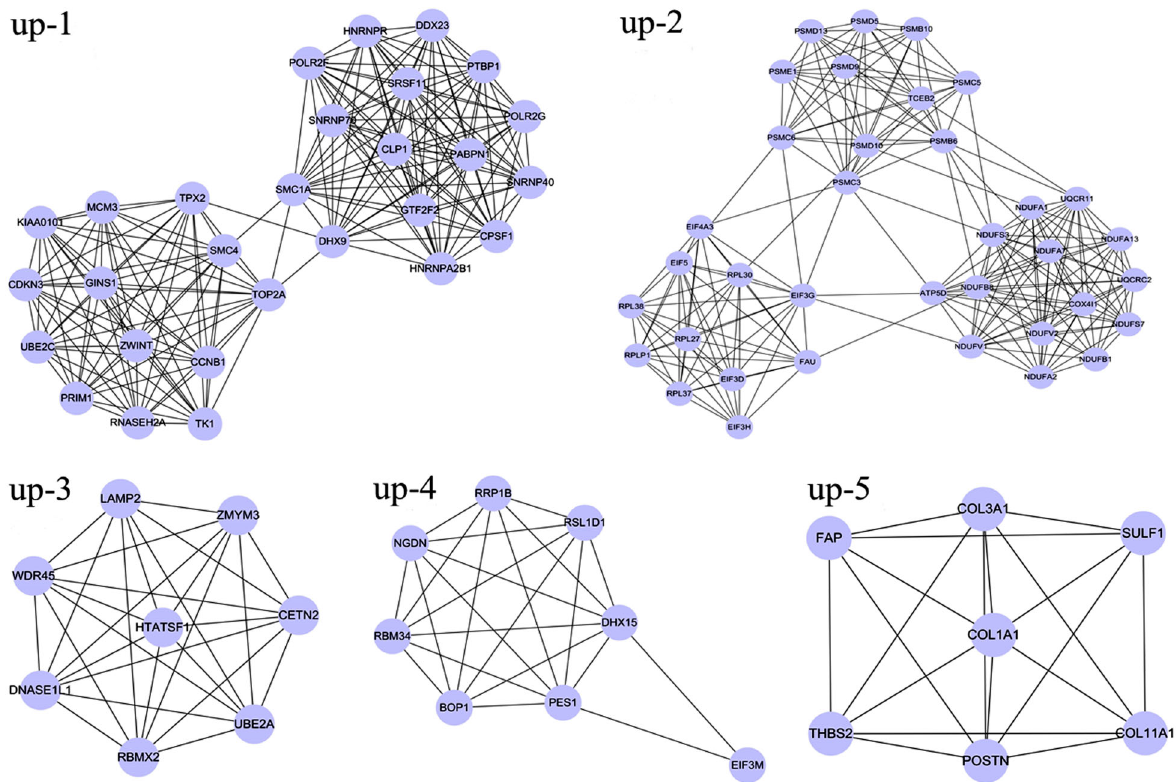
Figure 3. Modules of the protein-protein interaction network for upregulated differentially expressed